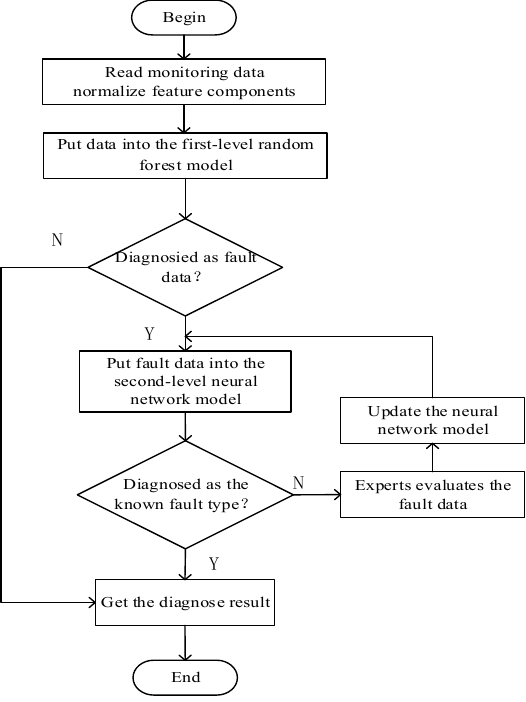
Figure 2. Flow chart of two-level fault diagnosis algorithm.